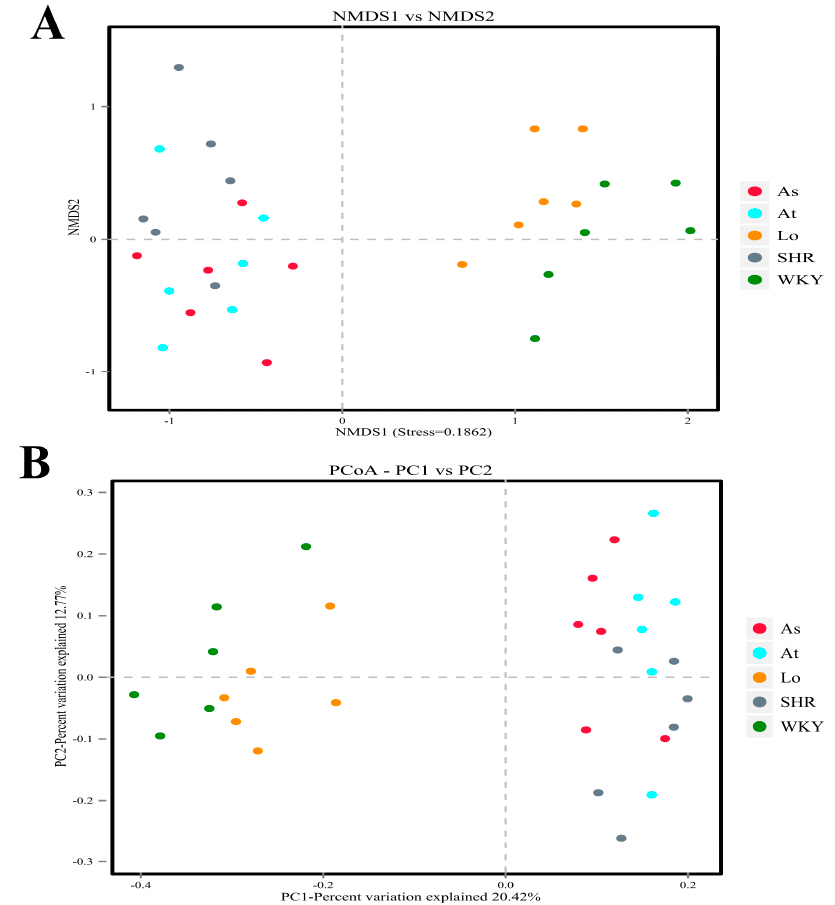
Figure 5. Beta diversity analysis. ( A ) Nonmetric multidimensional scaling (NMDS) is used to compare the differences between sample groups. Each point in the diagram represents a sample. The closer the distance is between the two points, the smaller the difference in the composition of the gut microbiota is. ( B ) Principal co-ordinates analysis (PCoA) was used to investigate the community similarity of gut microbiota. The closer the distance is between the two points, the higher the similarity in the composition of the gut microbiota is.